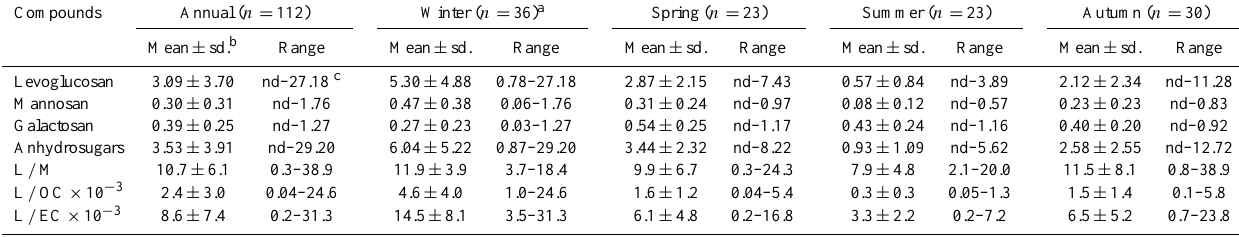
Table 1. Annual and seasonal means of anhydrosugars and ratios of levoglucosan to mannosan (L / M), OC (L / OC) and EC (L / EC). Compounds